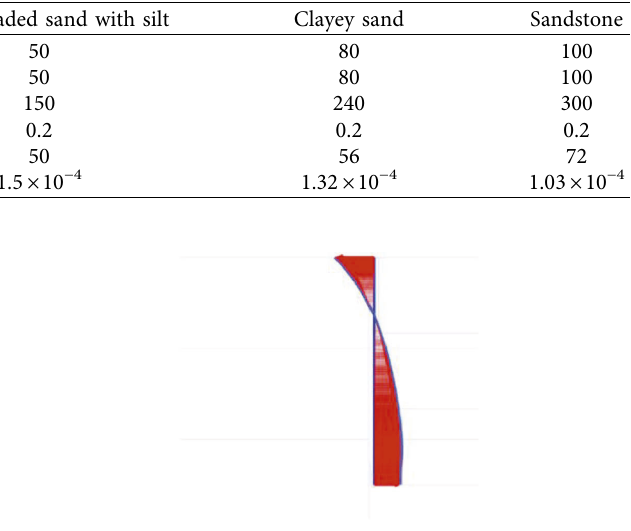
Figure 13: Horizontal displacement of pile head after prestressing (cambering effect).